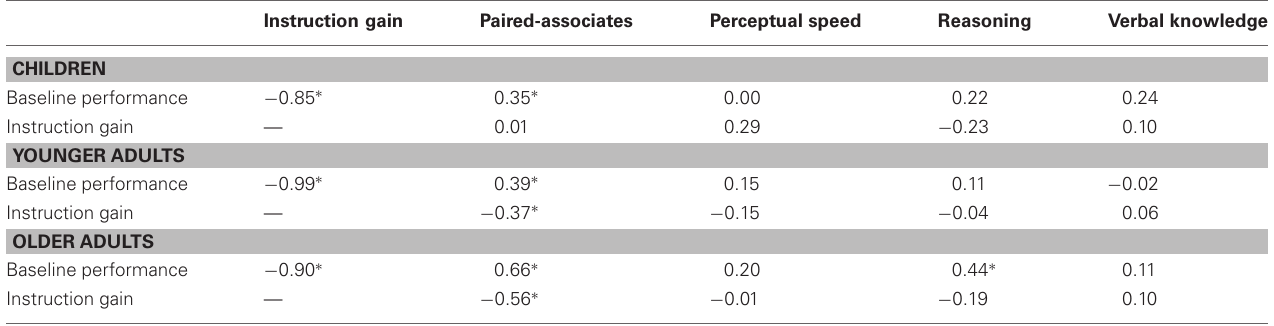
Table 3 | Correlations among cognitive composites, baseline memory performance, and gain in memory performance from baseline to post-instruction assessments (instruction gain) separately for the age groups.